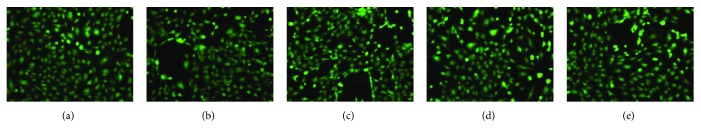
Live-dead cell staining: (a) control; (b): 20 ng TGF-β1; (c) TGF-β1+0.5 mM metformin; (d) TGF-β1+1 mM metformin; (e) TGF-β1+2 mM metformin. No obvious apoptosis of EPCs was observed in any group. However, there were some cellular morphological changes in (b) to (e); some stellate and flat cells were observed in these groups.